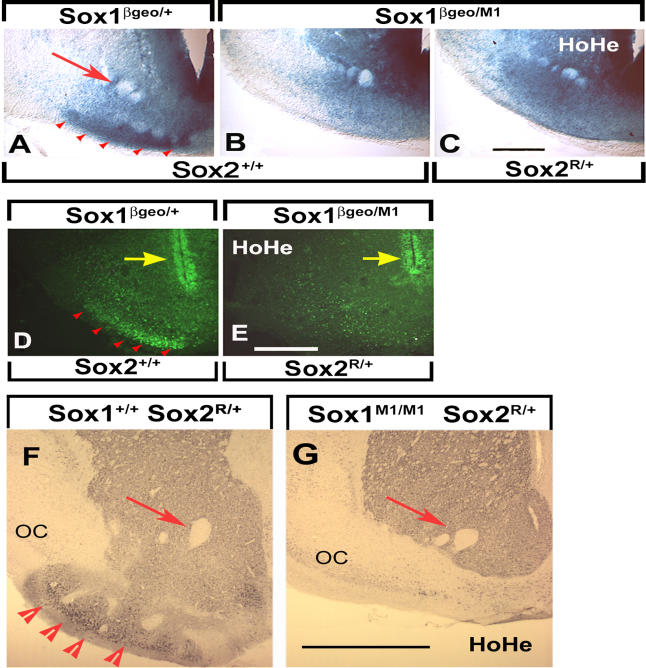

Sox1 Expression in Precursors Is Not Sufficient for the Emergence of OT/VS Neurons(A–C) X-gal staining of coronal sections from the ventral telencephalon showing Sox1-βgeo-expressing OT-prospective neurons at E16-stage embryos with one wild-type Sox1 allele, Sox1
βgeo/+, in (A), and none, Sox1
βgeo/M1, in (B), and HoHe (Sox1
βgeo/M1, Sox2
R/+) in (C). Note the absence of X-gal-stained neurons in the area of the VS (red arrowheads), indicating failure of the Sox2
R allele to rescue OT neuron development in the HoHe embryos. Expression of βgeo from the Sox2
R allele in the HoHe (C) may account for the slight increase of X-gal staining compared to (B).(D and E) SOX1 immunostaining at E16 embryos performed on the other halves of the brains of (A and C), respectively. Note that the level of SOX1 expression in the precursors (yellow arrows) is the same, whether it is expressed from the Sox2
R allele in the HoHe (E) or from one of the Sox1 wild-type alleles in the Sox1 single heterozygotes (D). Note in the HoHe (E), this expression is not sufficient for the development of OT neurons.(F and G) DARPP32 immunostaining of coronal brain sections from Sox1
+/+
Sox2
R/+ (F) and Sox1
M1/M1
Sox2
R/+ (G) P10 mice indicating loss of VS neurons.Red arrowheads indicate OT; red arrows indicate anterior commissure. OC, olfactory cortex. Scale bar = 500 μm (A–E), 1 mm (F and G).